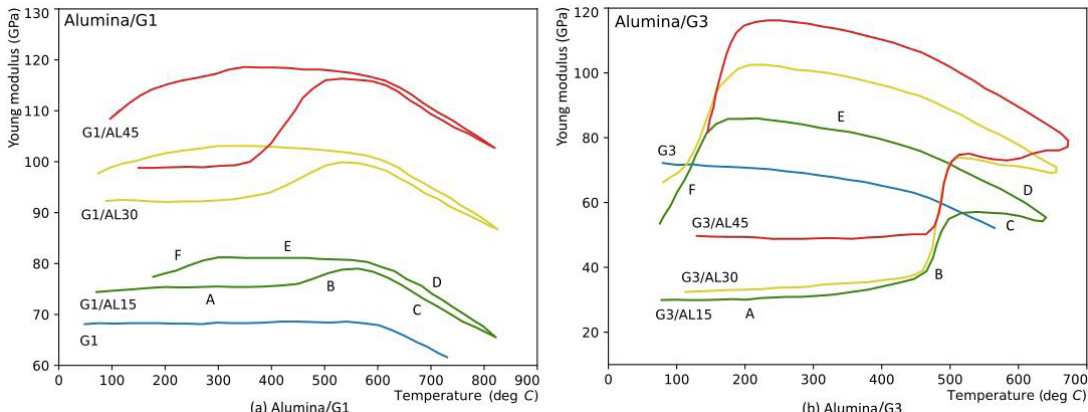
Figure 3. Temperature-dependent Young modulus of Alumina/G1 and Alumina/G3. Experimental data obtained by Tessier-Doyen 7